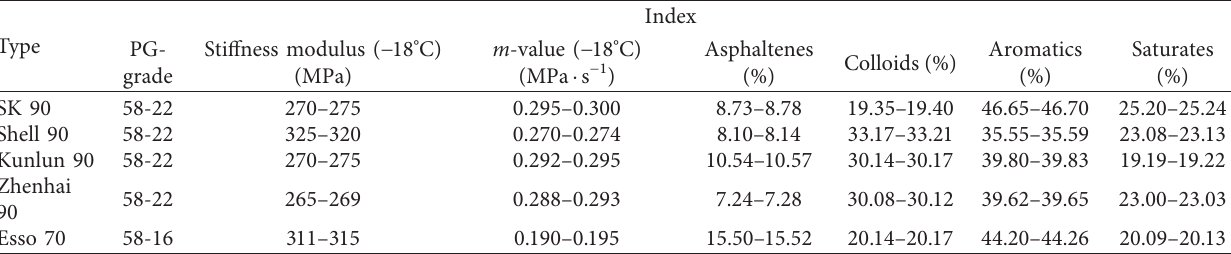
Table 1: Test parameters and their indexes of matrix